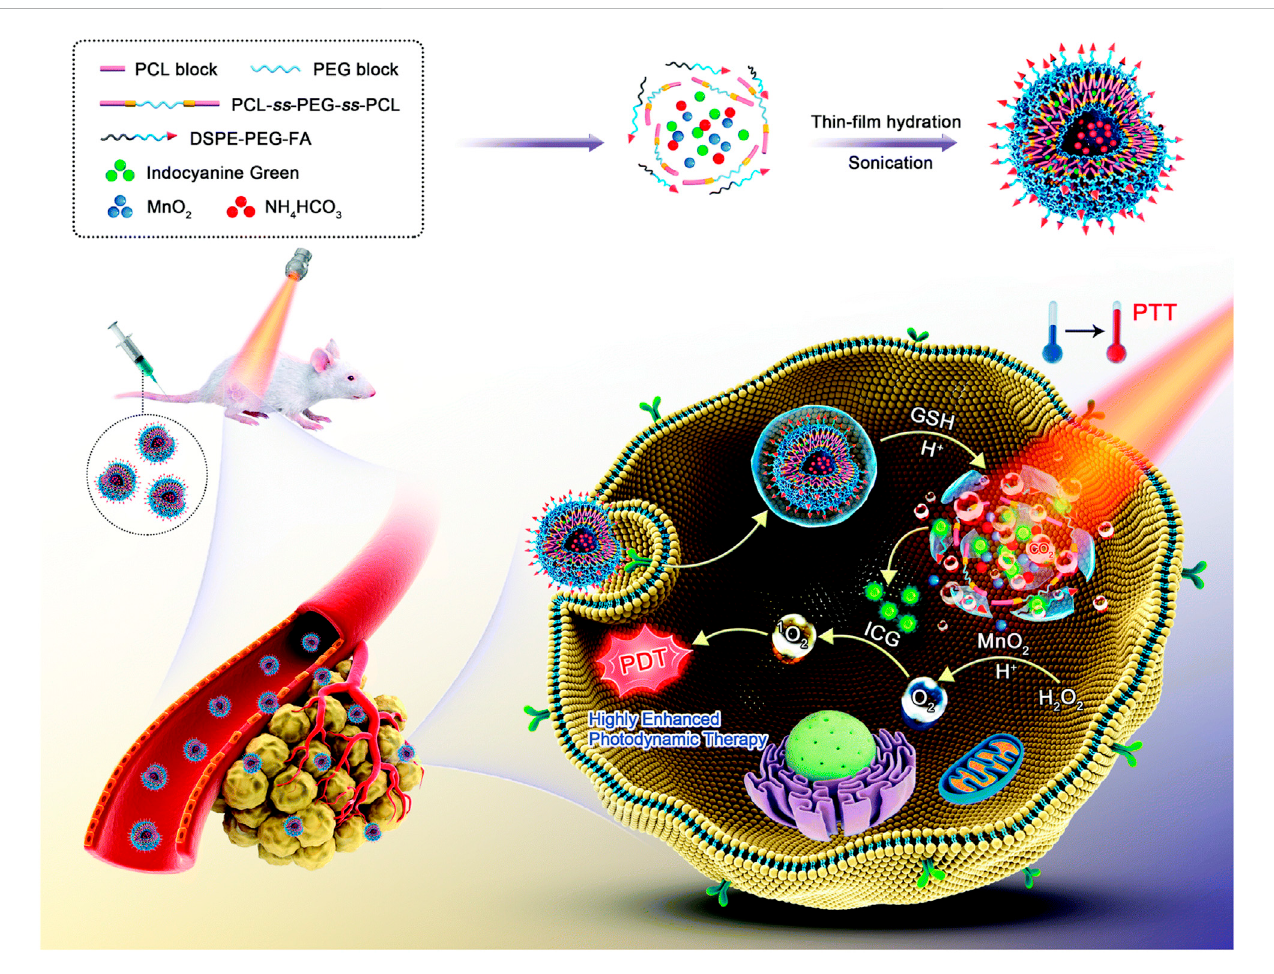
FIGURE 6 Schematic illustration for the formulation and enhanced photothermal – photodynamic combination therapeutic mechanism of oxygen- and bubble- generating polymersomes (FIMPs). Reproduced with permission from (Li et al., 2021b) Copyright (2021) Royal Society of Chemistry.